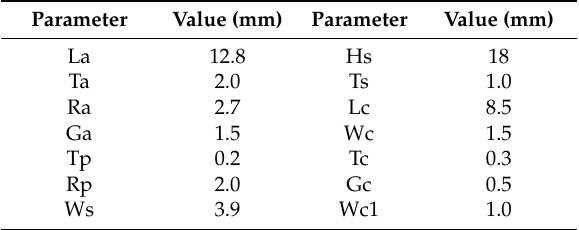
Table 2. Geometrical parameters of the proposed antenna.